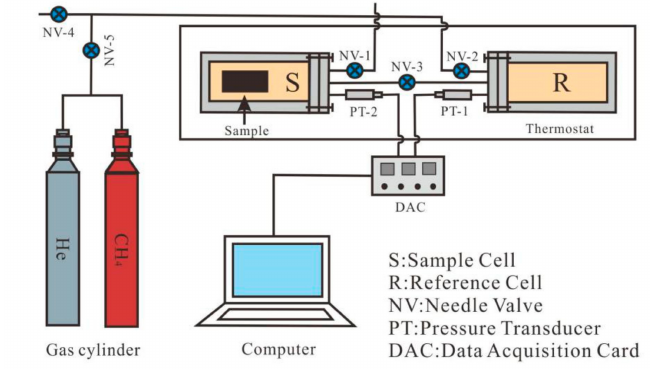
Figure 2. Experimental devices for CH 4